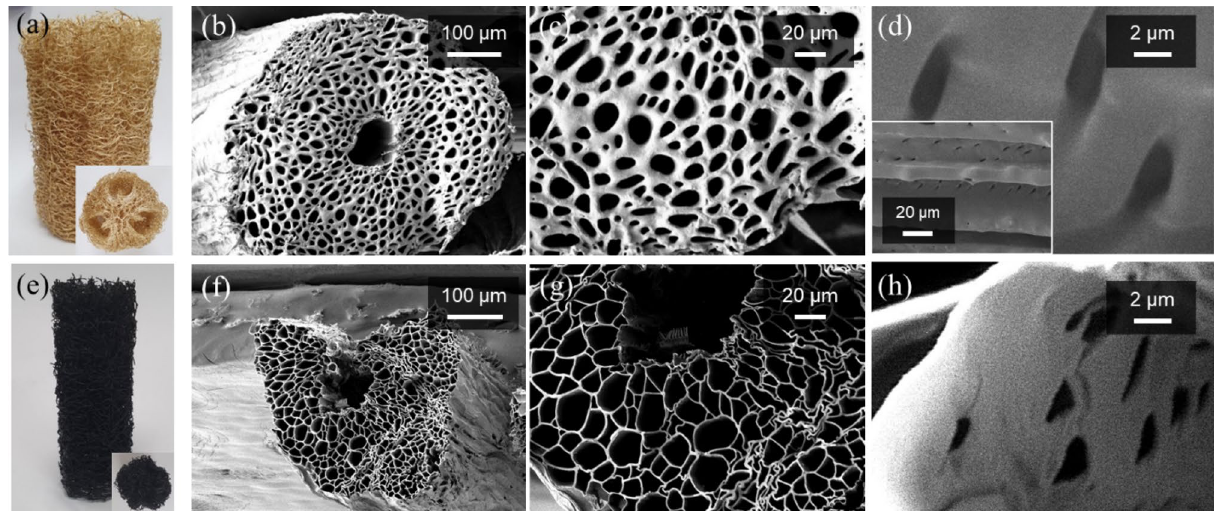
Figure 1. ( a ) Photograph of the DLS. The inset shows the cross-sectional image. ( b ) Cross-sectional SEM image of the LF and ( c ) its magnified image. ( d ) Cross-sectional SEM image of the LF in the fiber-length direction. The inset image at low magnification shows that micro-sized pores exist on the microchannel surface. ( e ) Photograph of CLS. The inset shows the cross-sectional image. ( f ) Cross-sectional-view SEM image of a CLS fiber and ( g ) its magnified image. ( h ) Cross-sectional SEM image of a CLS fiber in the fiber-length direction.